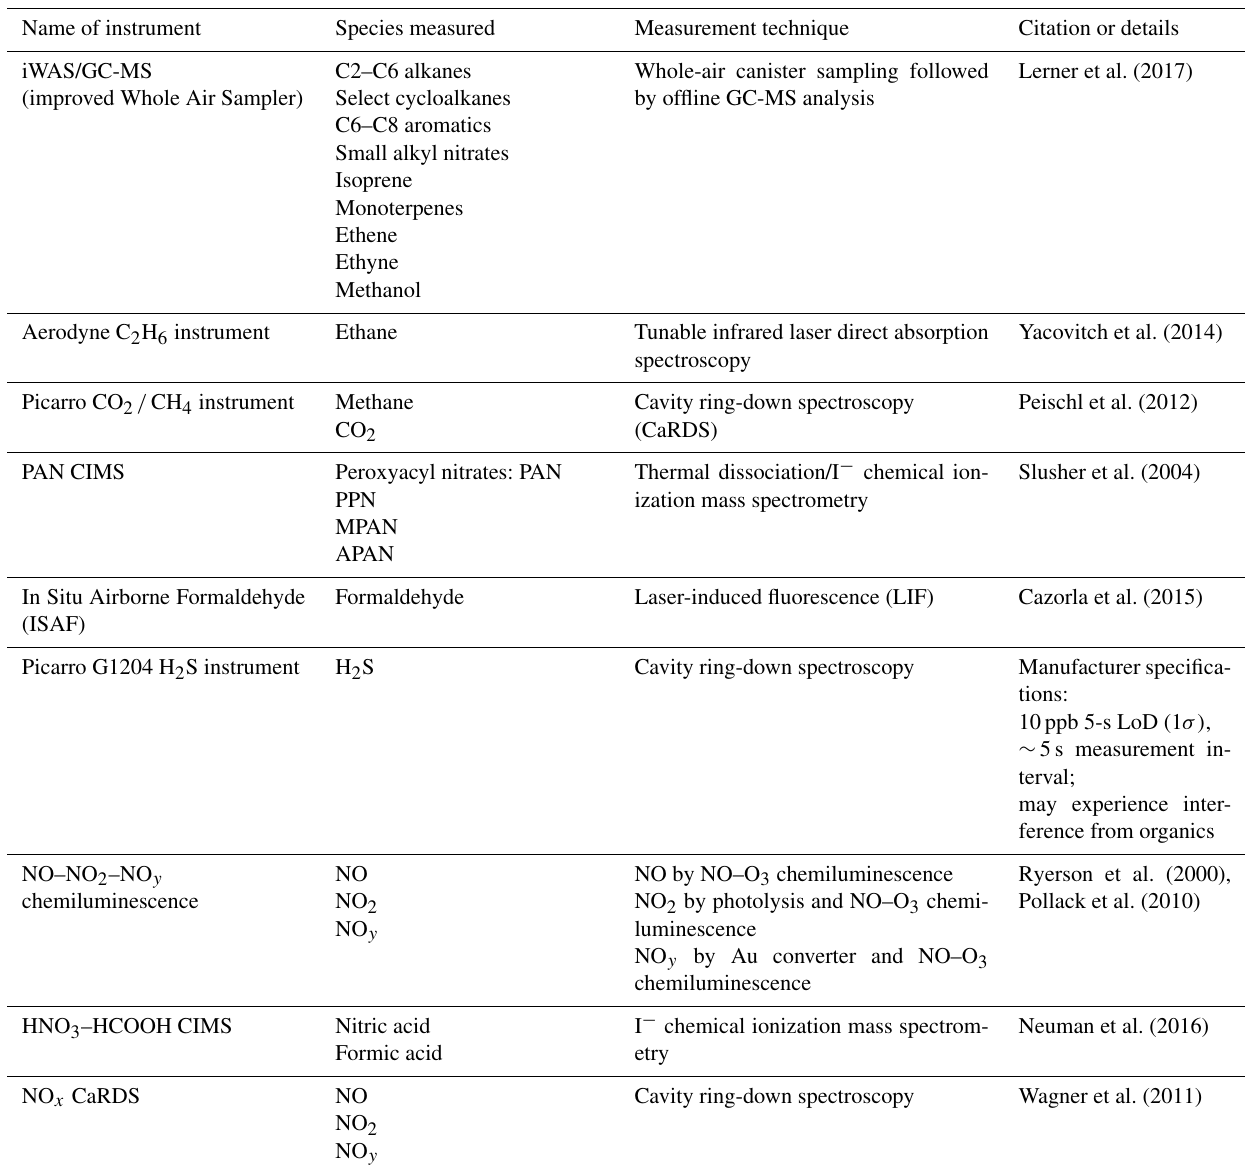
Table 1. SONGNEX chemical